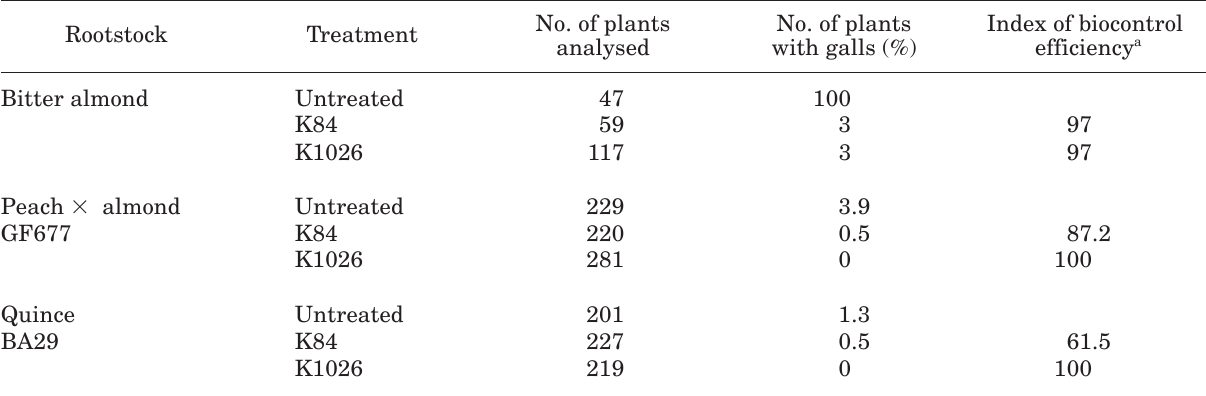
Table 6. Effect of the antagonistic Agrobacterium radiobacter strains K84 and K1026 on gall formation in rootstocks under field